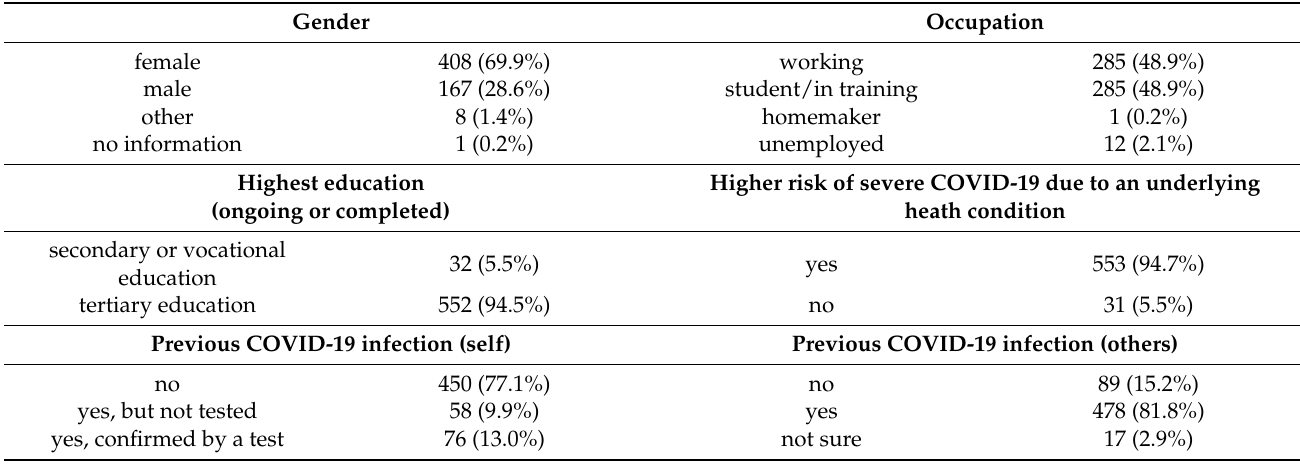
Table 1. Sample characteristics ( N =